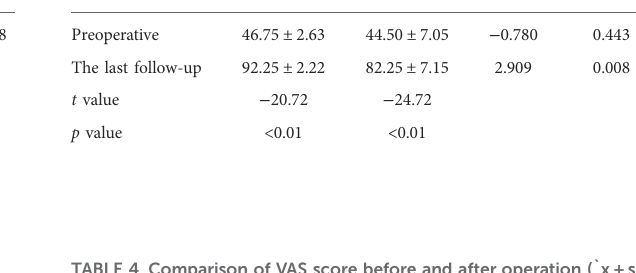
TABLE 4 Comparison of VAS score before and after operation